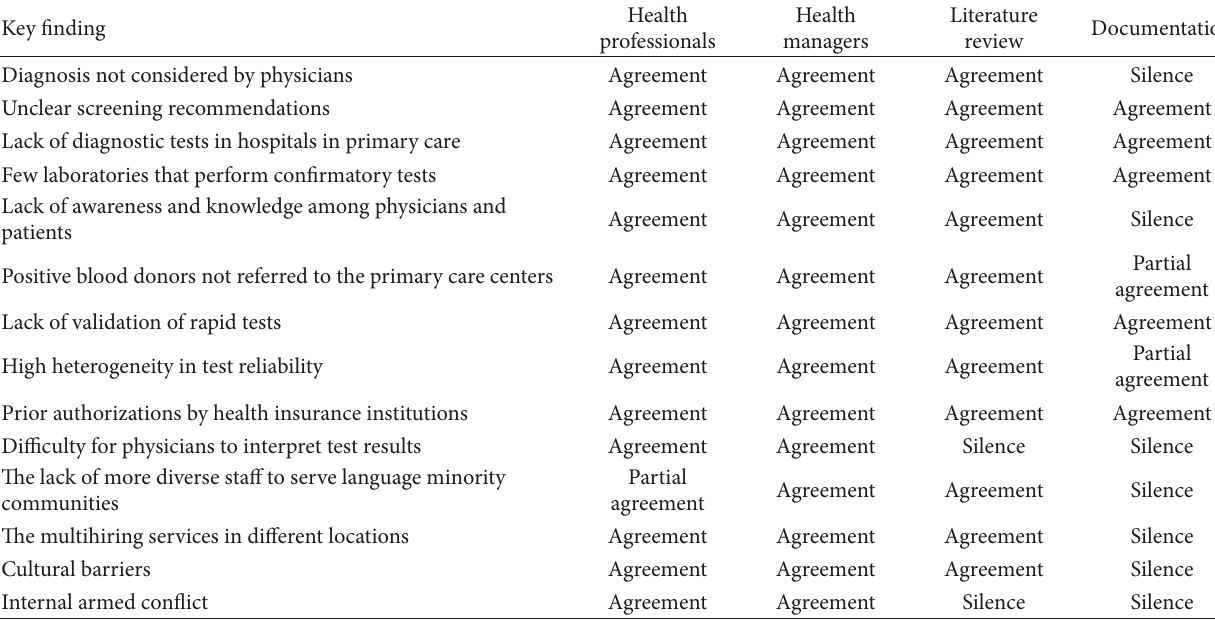
Table 4: Integration of the main findings across the constitutive